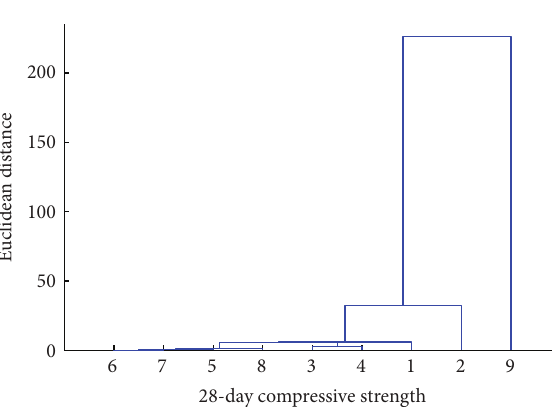
Figure 18: Dendrogram obtained.